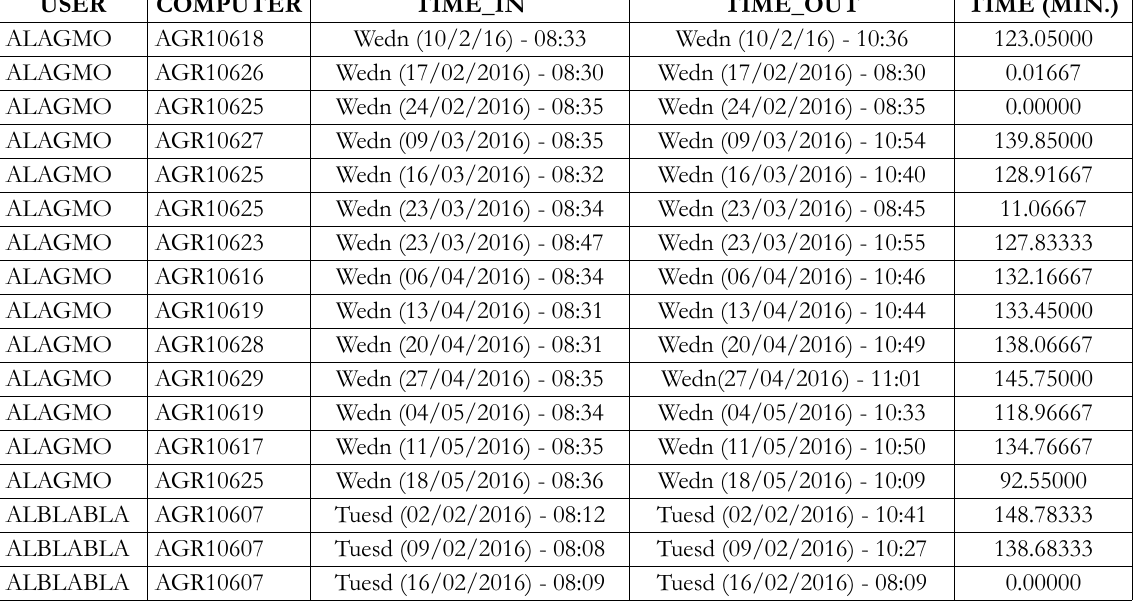
Table 1. SHEET 1. Access log to computers during practice sessions